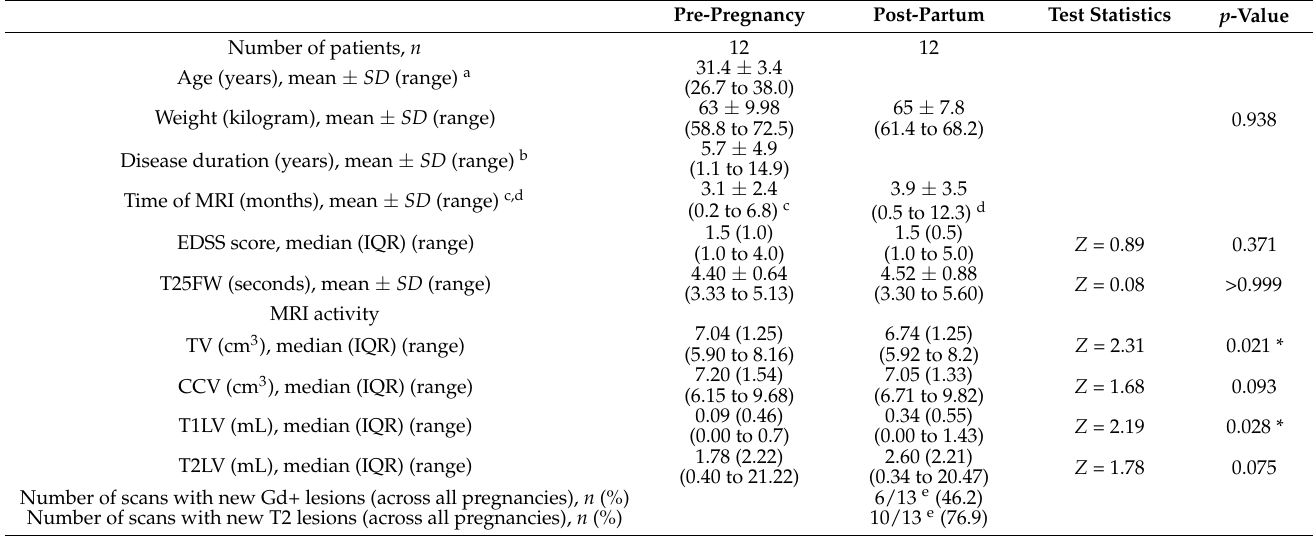
Table 1. Patient demographic, clinical and MRI characteristics. Pre-Pregnancy Post-Partum Test Statistics p